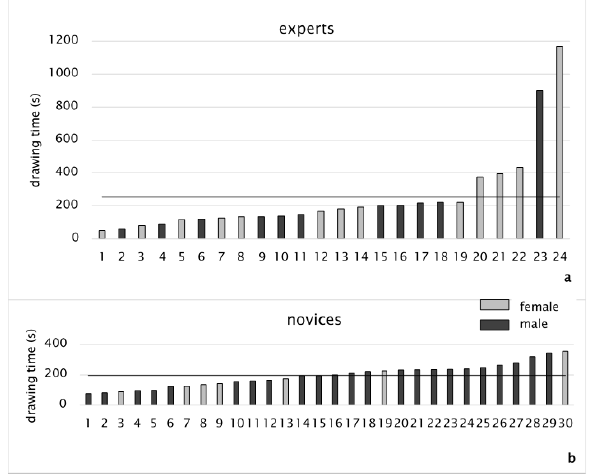
Figure 5. Drawing time of experts (a) and of novices (b) (black line: